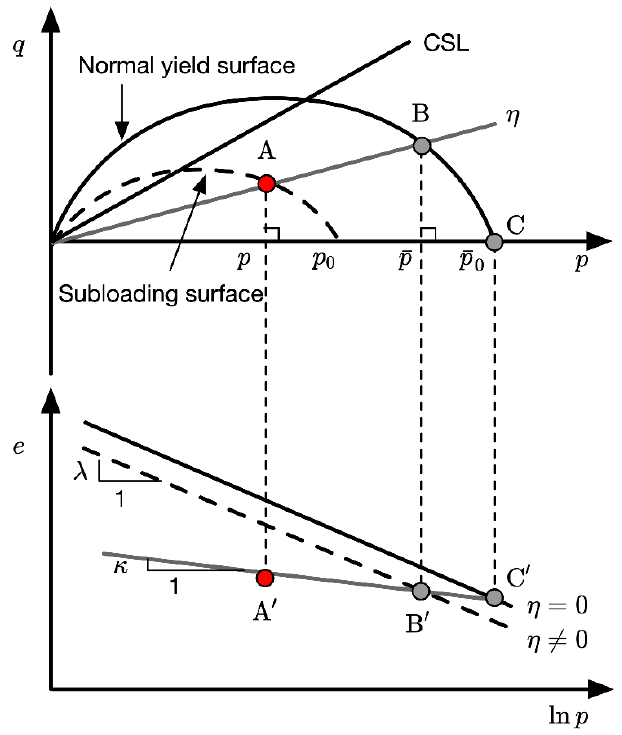
Figure 3. The schematic diagram of sub-loading and normal yield surfaces.